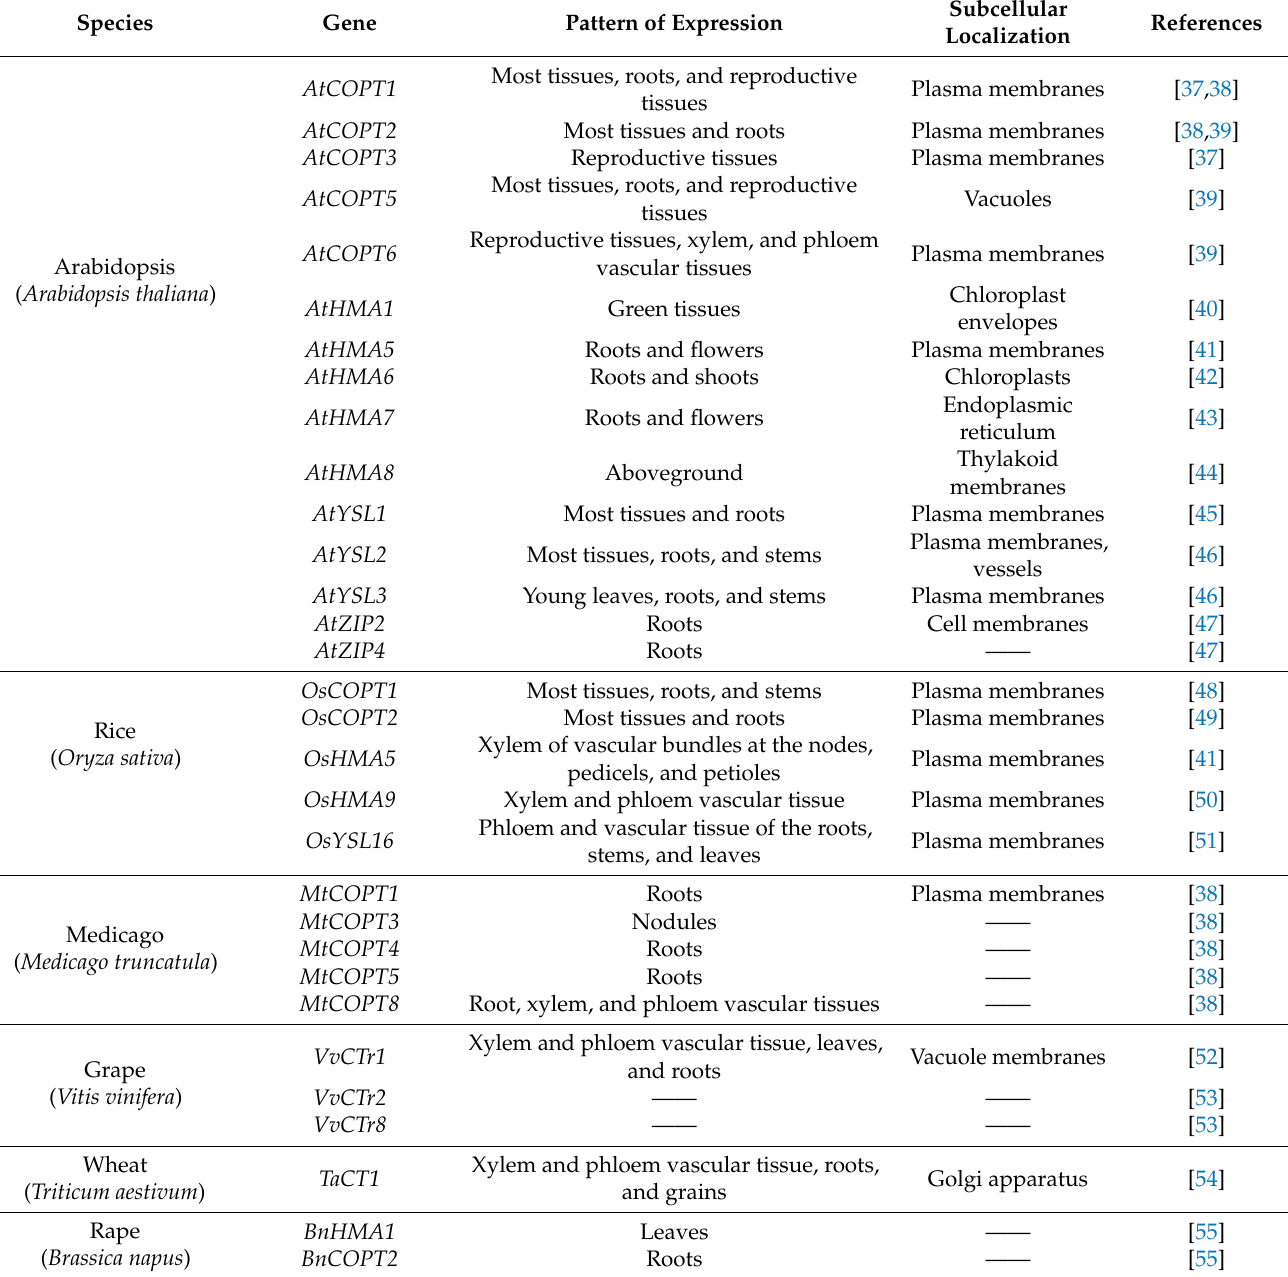
Table 1. Copper uptake and transport genes in different